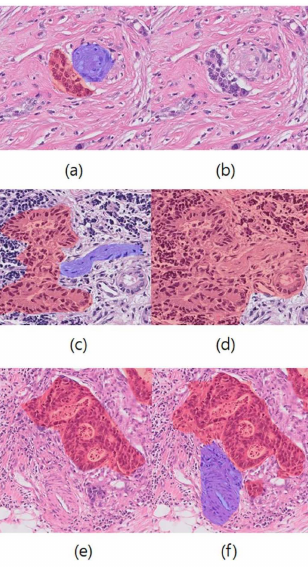
Figure 4. Examples of misclassification with ground truths ( a , c , e ) and the corresponding prediction ( b , d , f ). ( b ) In the false negative (FN) case, both tumor and nerve tissues were missed. ( d ) In the other FN case, nerve tissue surrounded by tumor tissue was predicted as tumor tissue. ( f ) In the FP case, nerve tissue was falsely predicted as a blood vessel. All the inference results from each pipeline are found on the webpage (http://pni.ssus.work/, accessed on 13 September